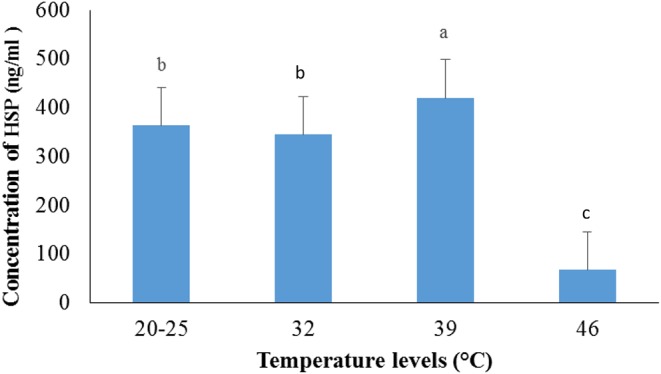
Variation of serum HSP-40 in male guinea pig exposed to different levels of temperature.